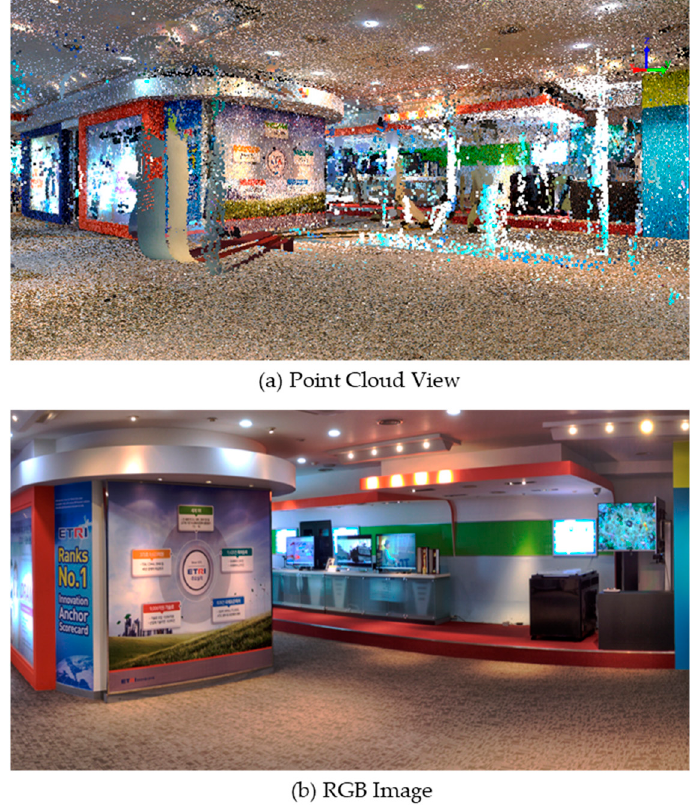
Figure 2. Noise area overview. Part ( a ) is the noise region shown through the point cloud view. ( b ) is the RGB image in the same view.